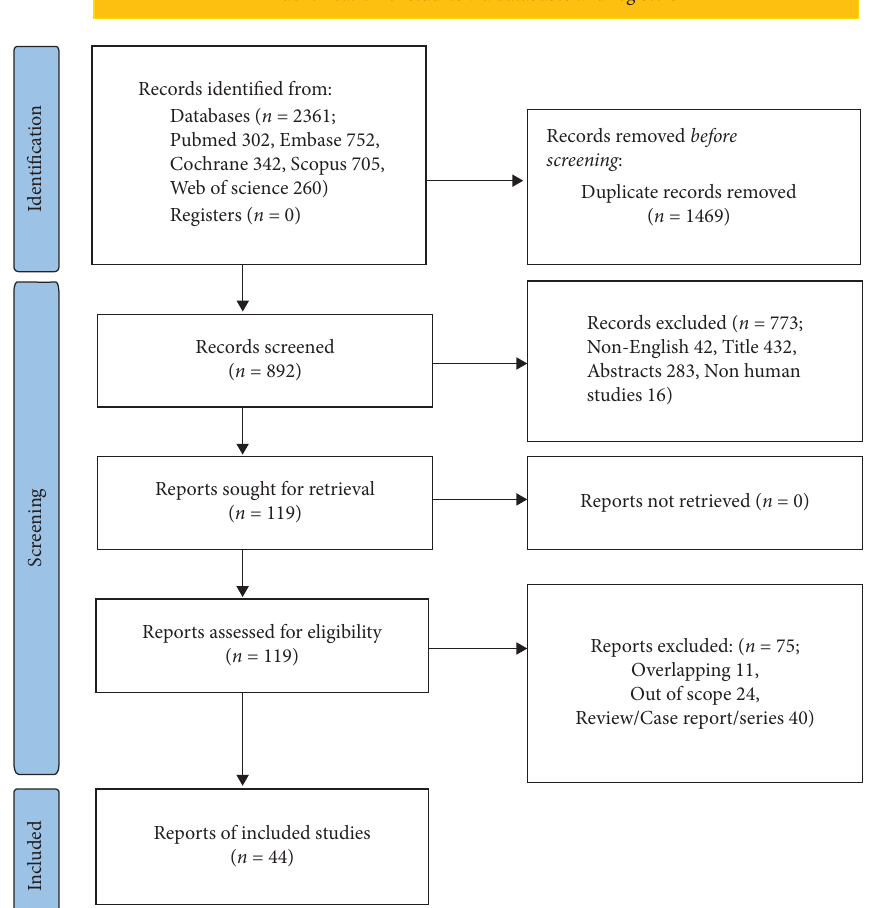
Figure 1: PRISMA fow chart illustrating the study selection